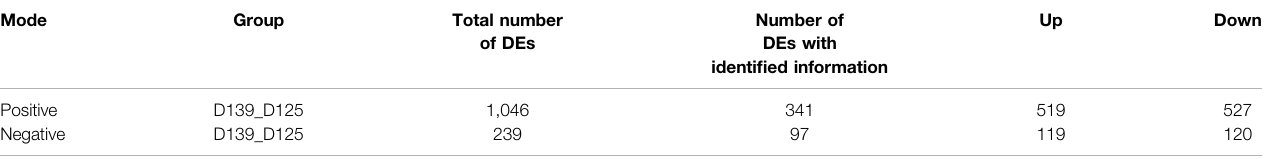
TABLE 4 | Statistics of differential